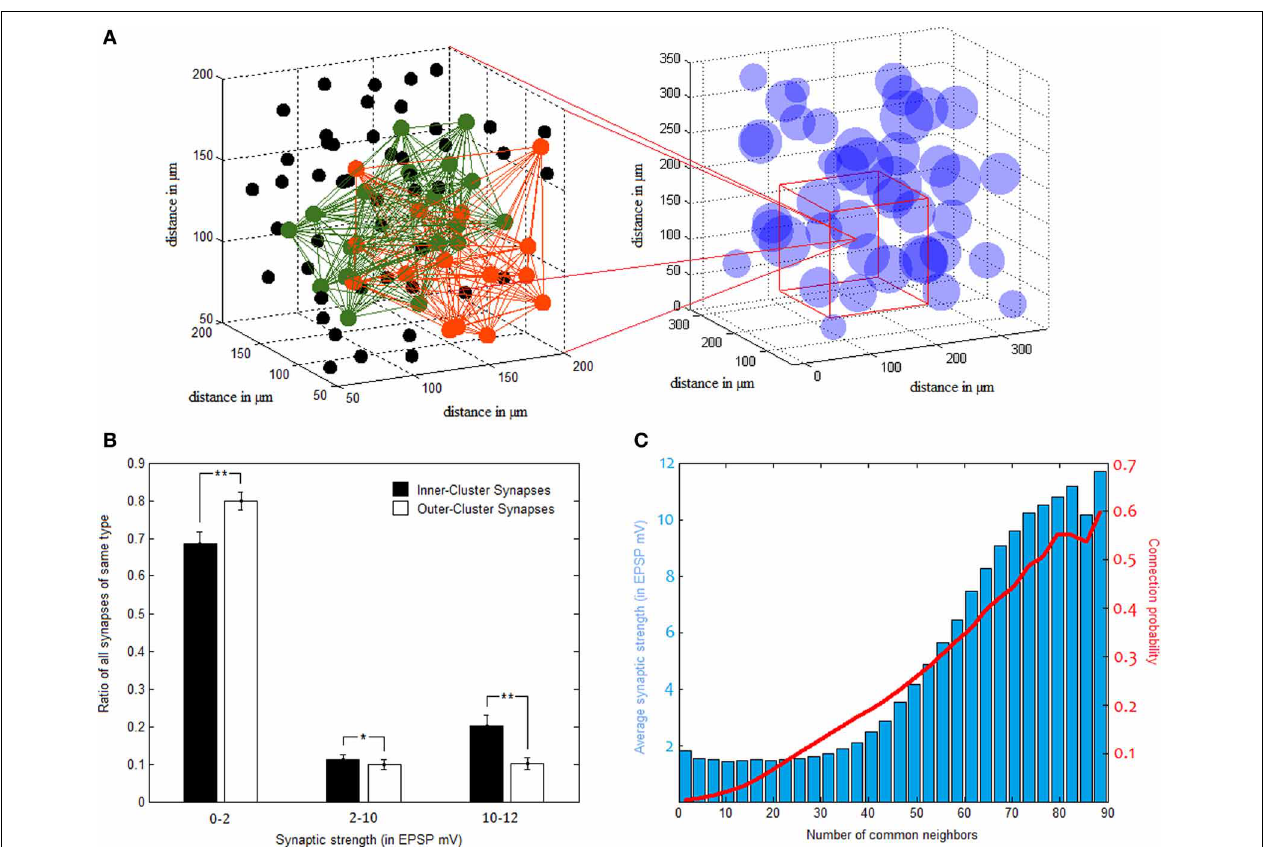
FIGURE 4 | Pyramidal clusters. (A) Illustration of cluster overlap. On the right—cluster distribution in 3d space. Clusters are drawn as spheres using their calculated center point and average diameter. They overlap substantially, as can be seen zooming in to a region (on the left hand side). Two different clusters, colored green and orange, interlace in this space. Black dots indicate neurons which belong to